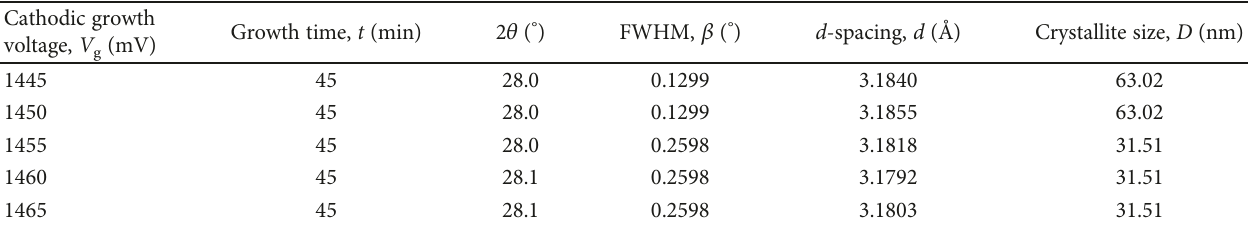
Table 2: XRD analysis of the (101) hexagonal peak for annealed CdS thin fi lms deposited at di ff erent cathodic voltages. Cathodic growth Growth time, t (min) voltage, V (mV) g